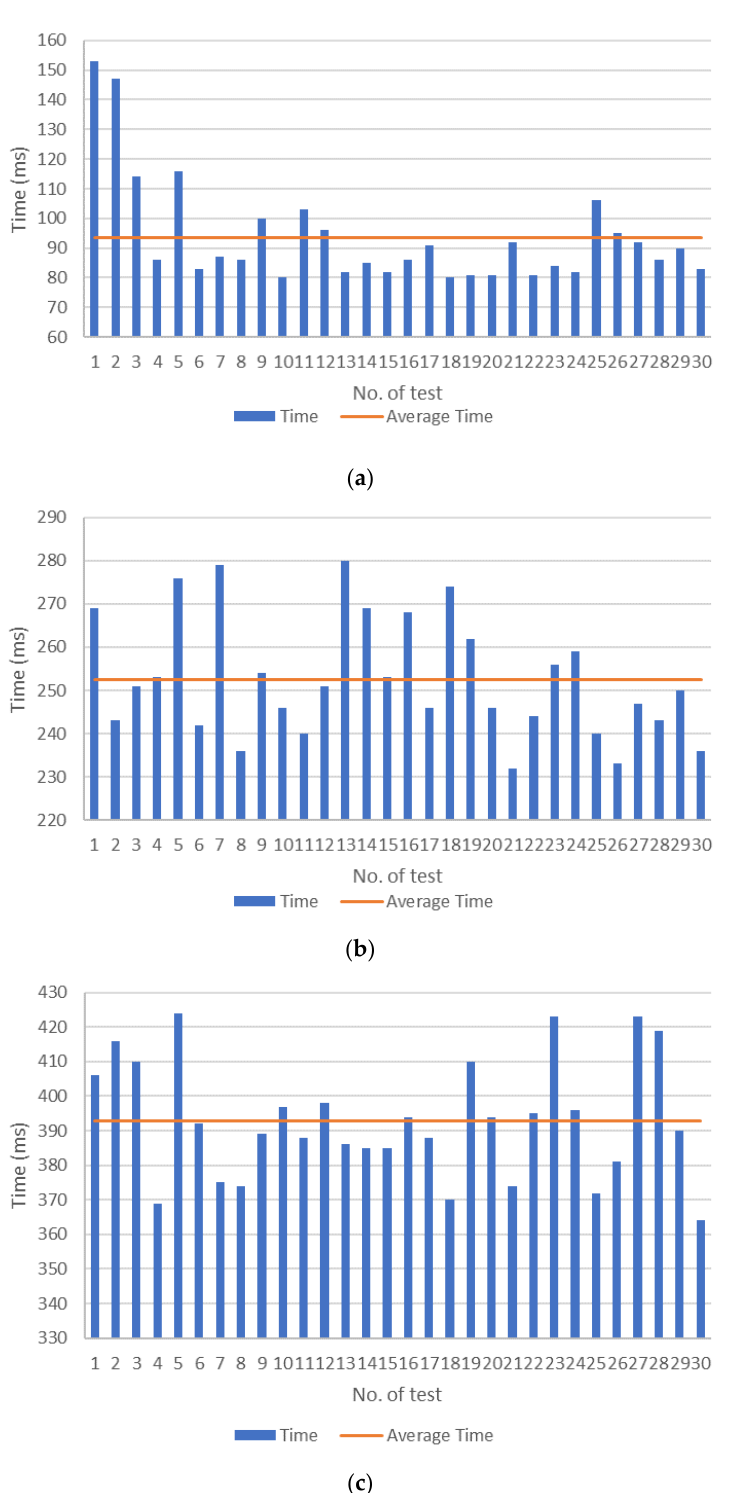
Figure 9. Test results of query operations. ( a ) 10 queries (max: 153; min: 80; mean: 94); ( b ) 30 queries (max: 280; min: 232; mean: 253); ( c ) 50 queries (max: 424; min: 364; mean: 393).